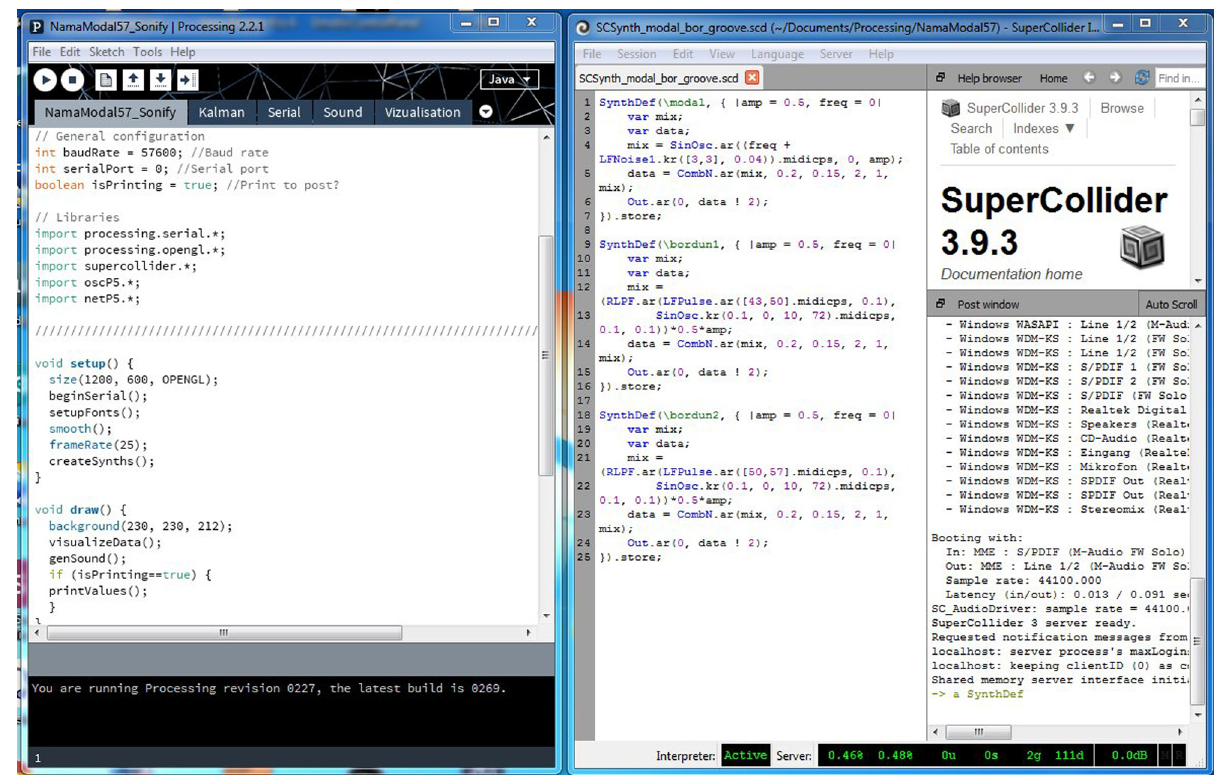
Figure 23: Processing and SuperCollider programs for soni fi